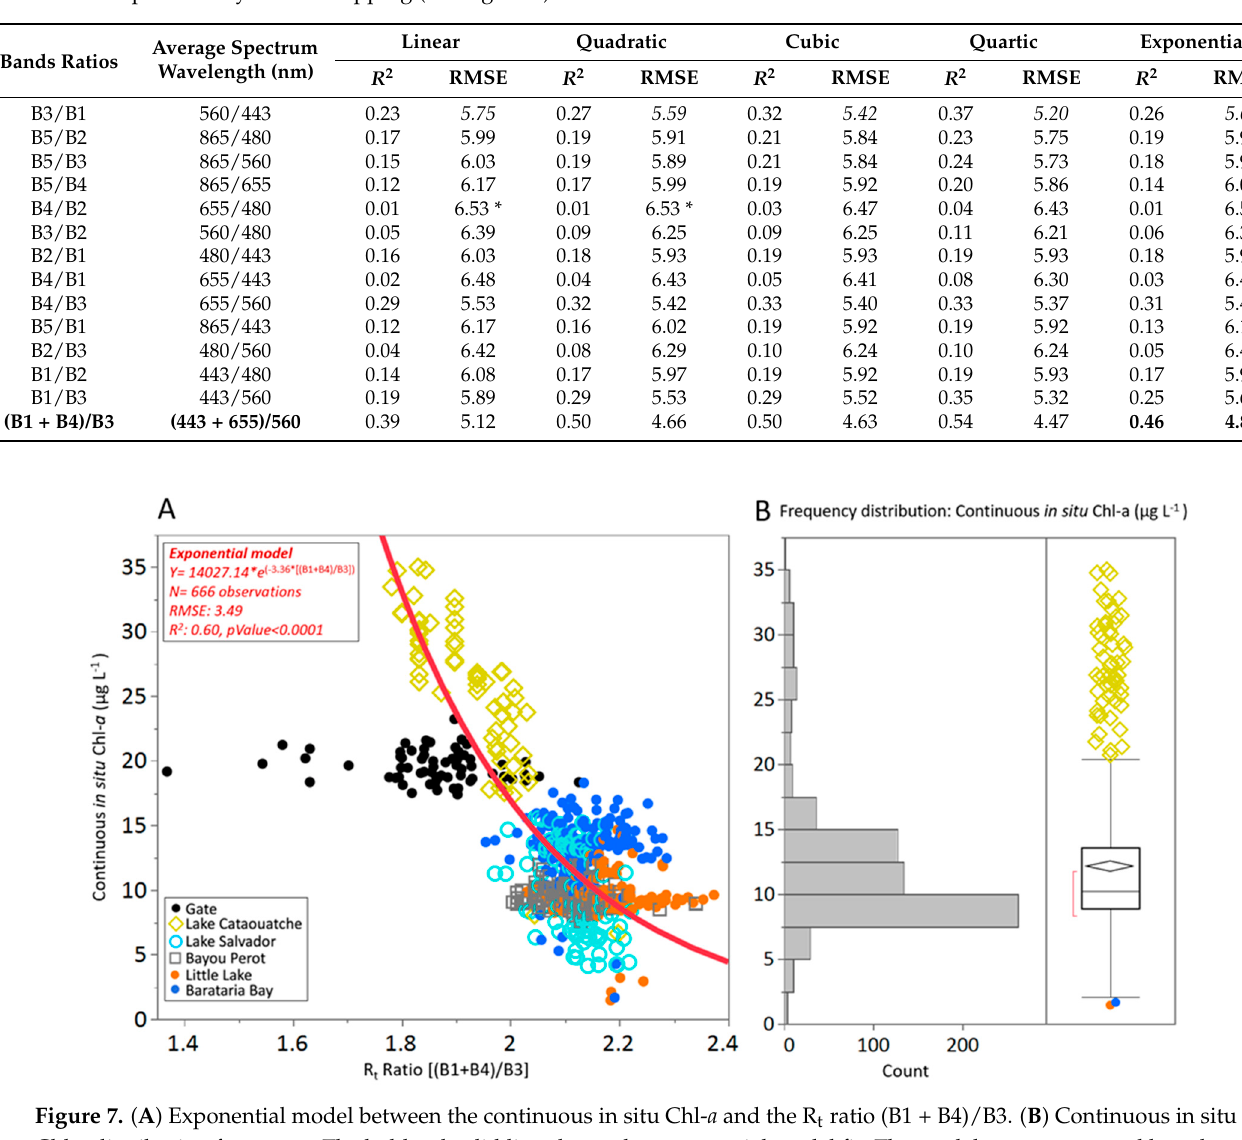
Table 1. Linear, polynomial, and exponential band regression results between continuous in situ Chl- a and L8/OLI surface reflectance data (R t ). Modeling was performed using 1441 sampling points distributed throughout the BB complex along salinity gradients collected on 22 February 2020 (see methods). R 2 , coefficient of determination; RMSE, root mean square error. All values are significant at p < 0.0001, except when p ≤ 0.0002 (*). Bold text and numbers indicate the selected model used for spatial analysis and mapping (see Figure 8).